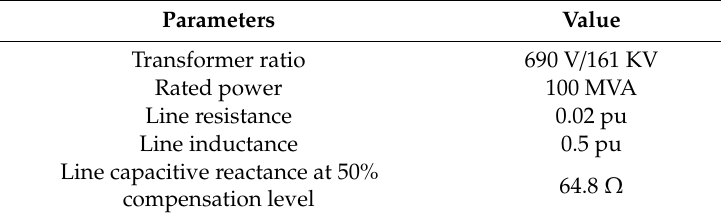
Table A2. Parameters of Network